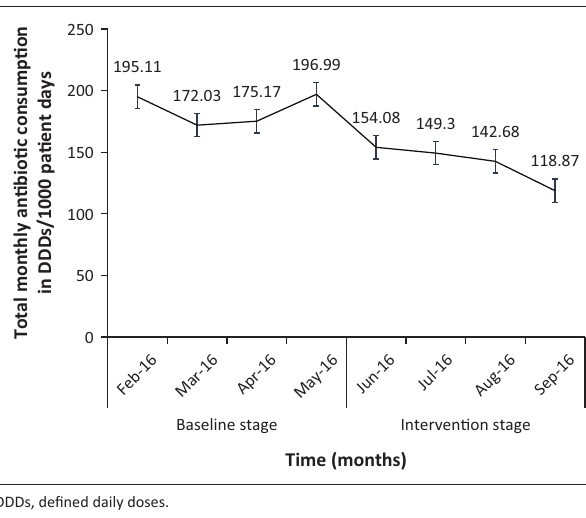
FIGURE 1: Trend of antibiotic consumption over the study period. TABLE 4: Frequency of top 10 antibiotic prescribed over a 10-month period in the general and vascular surgical wards. Name of antibiotics